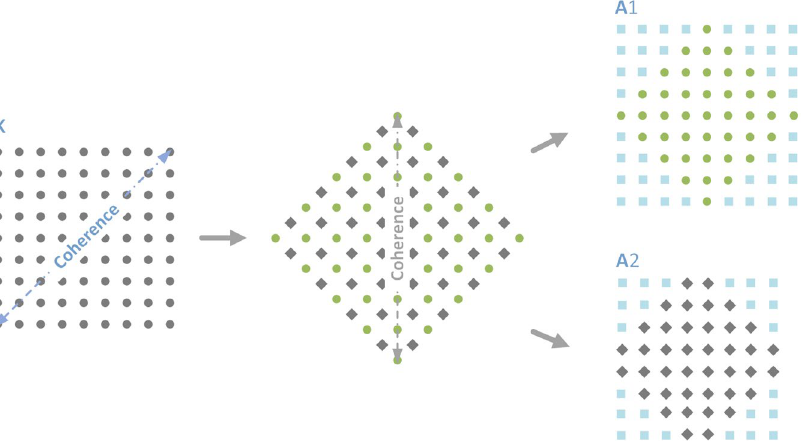
Figure 2. Principle of the matrix rotation by taking the example of a matrix K with a dimension N = 9. The gray circles donate the whole elements of K . By rotating the matrix 45 degrees, the coherence of the direct waves appears along the columns and all the elements are divided into the green circle part and gray diamond part according to the symmetry characteristics. Finally, these two parts are extended into two new matrices A 1 and A 2. The value of the blue square elements is